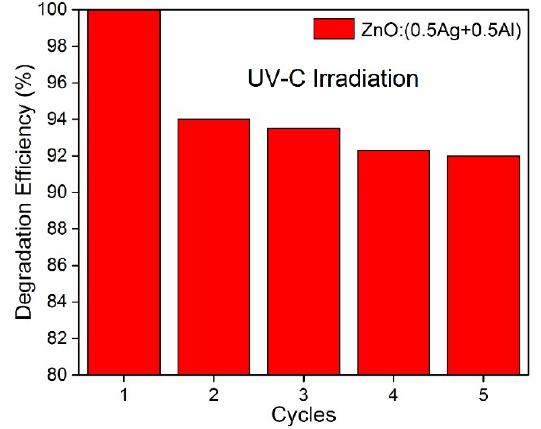
Figure 10. Photocatalytic activity of ZnO:Ag + Al film for degradation of rhodamine B under UV‐C irradiation: ( a ) concentration change over time and ( b ) degradation efficiency.